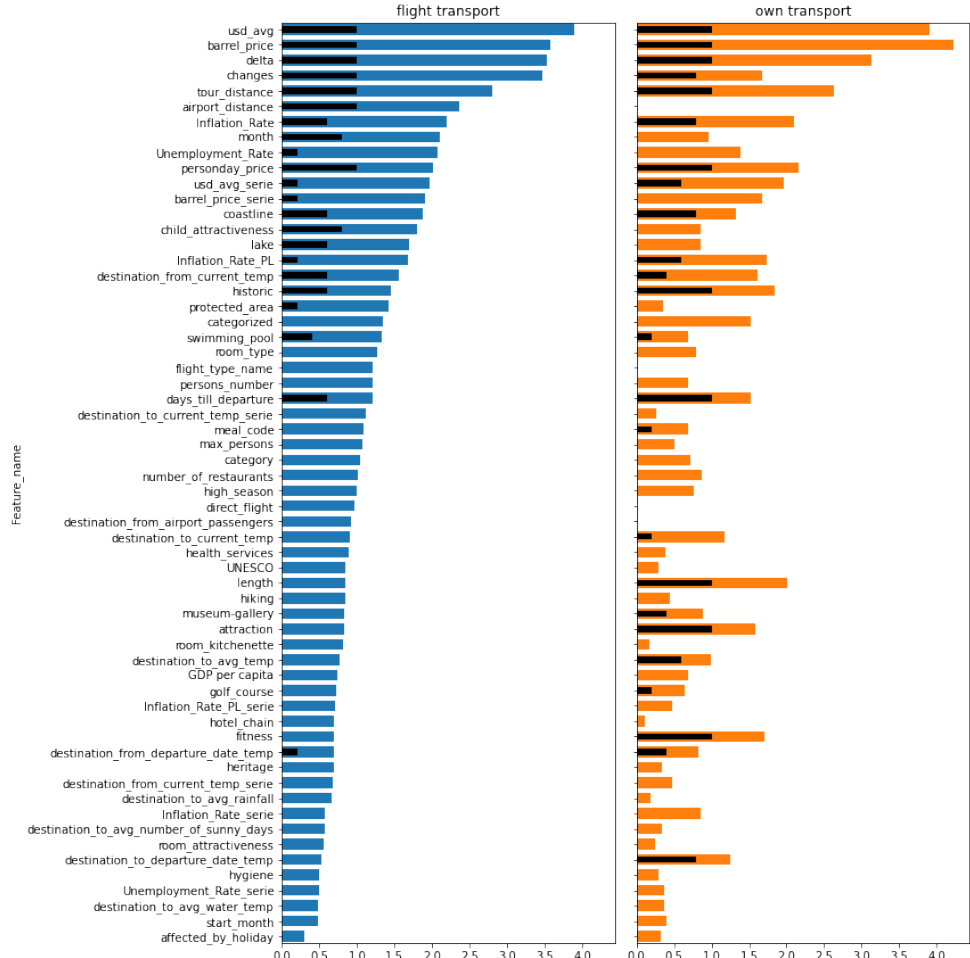
Figure 11. Final evaluation of features for n = 28. Blue and orange bars present the sum of the weights obtained by all five methods. Black bars indicate the result obtained using sequential backward